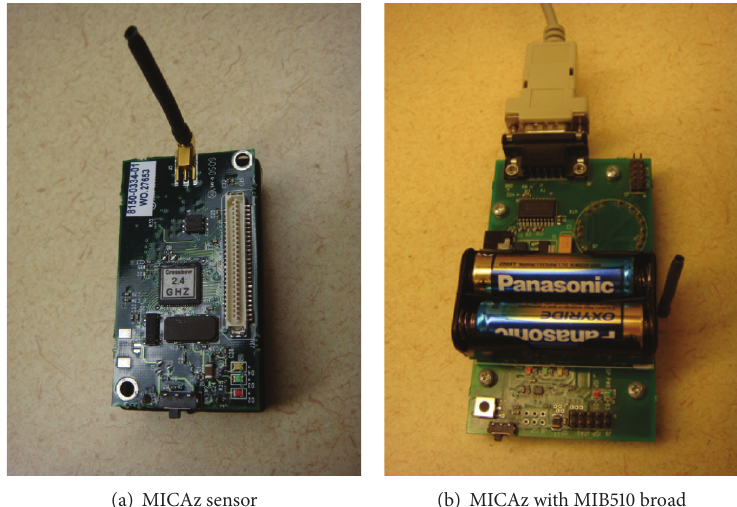
Figure 4: (a) Deployed sensor device and (b) base station device.